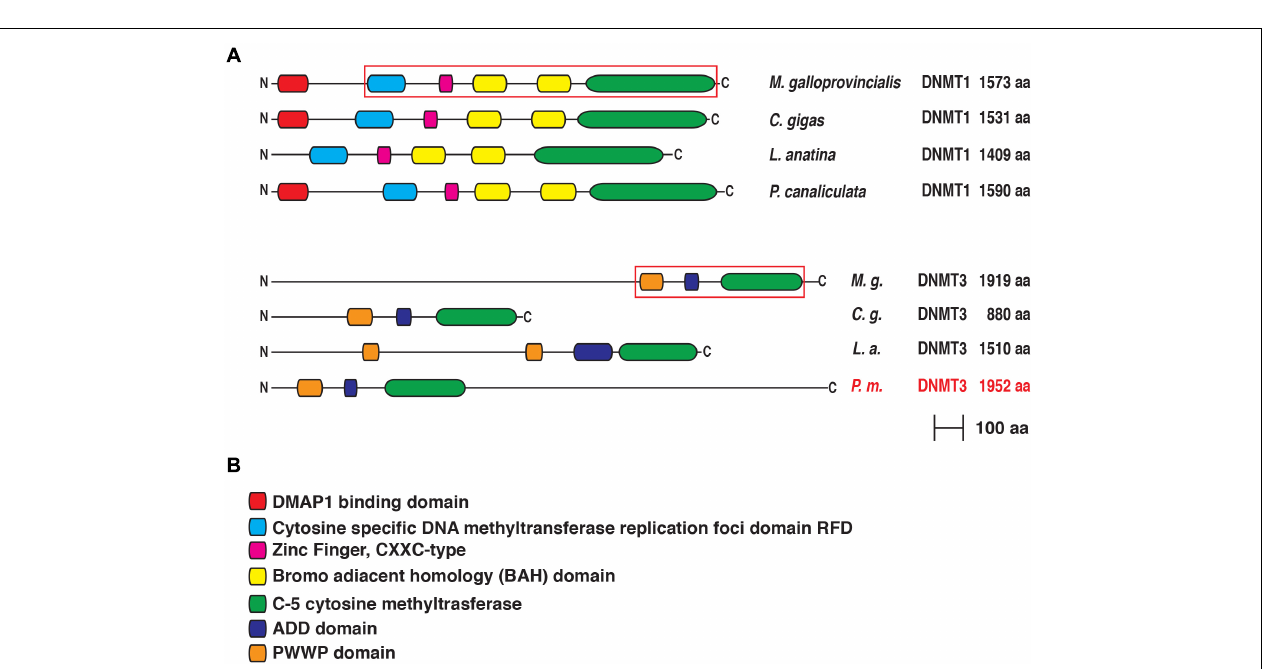
FIGURE 1 | Exon-Intron structure of M. galloprovincialis Dnmt1, Dnmt3, Tet, Mbd 2/3, and Mbd4 genes. The red square indicates the optional 39 bp region alternatively spliced in the exon 2 of the Mbd2/3 gene. The two different lengths refer to the Mbd2/3a and Mbd2/3b variants.